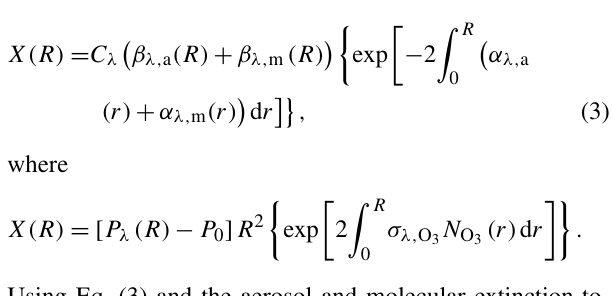
Figure 2. (a) A histogram of the average HALO S 1 frequency dis- tribution for the afternoon of 28 August, and (b) a histogram of the 5, 6, 15, 16, 24, 28, and 29 August 2018 measurements during the LISTOS